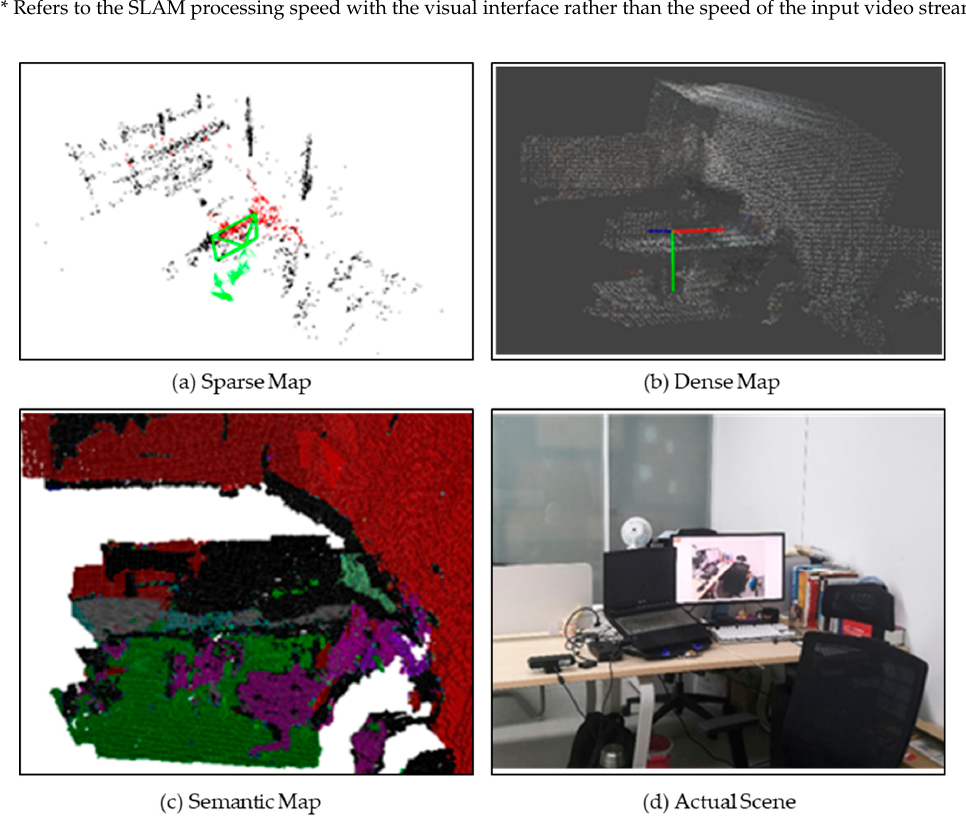
Figure 6. Different maps generated by the proposed semantic visual SLAM. Table 2. SLAM execution speed evaluation.